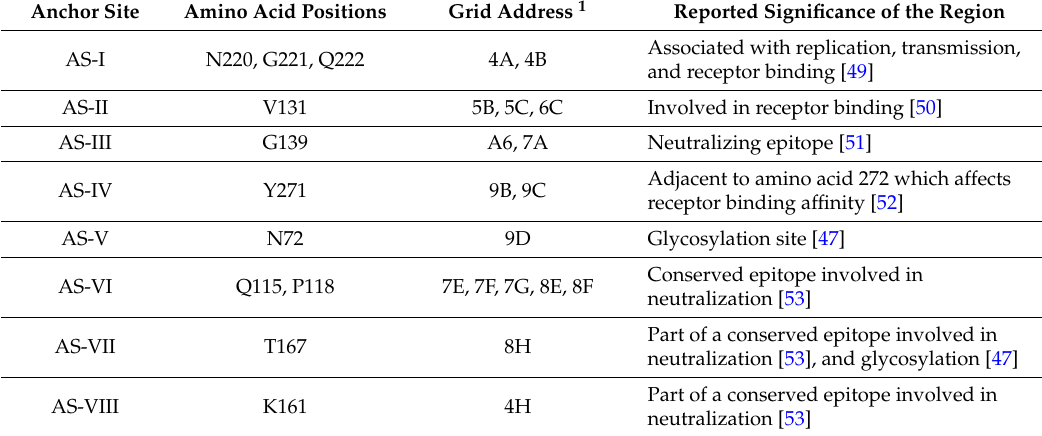
Table 1. Avian influenza virus hemagglutinin subunit 1 (AIV HA1) anchor sites (AS). Anchor Site Amino Acid Positions Grid Address 1 Reported Significance of the